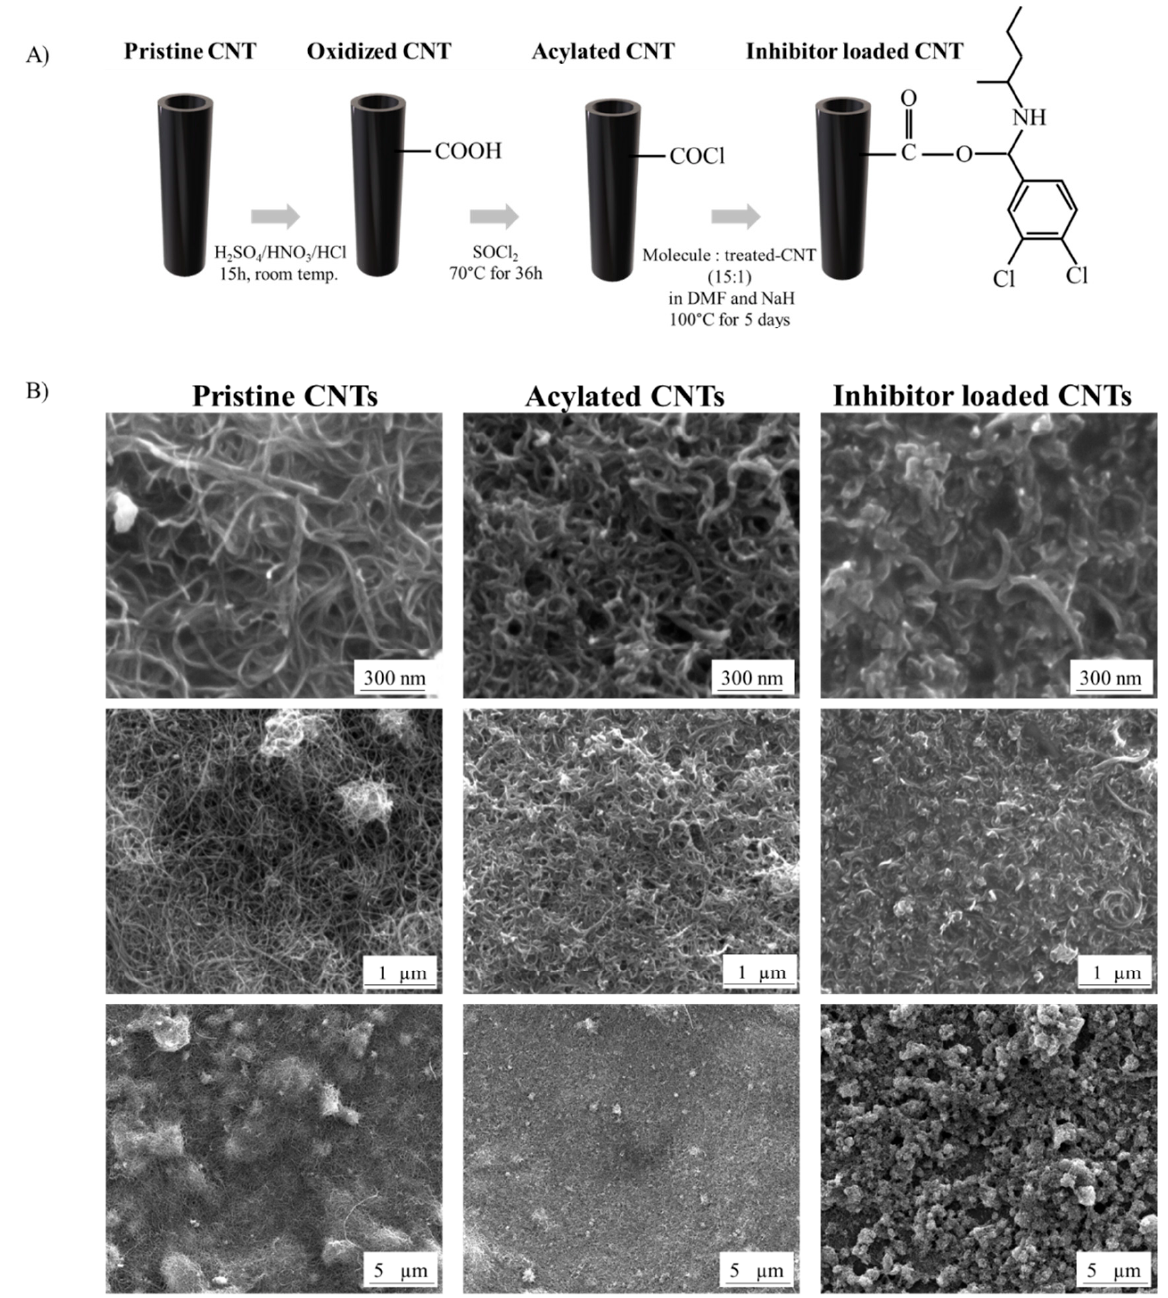
Figure 1. ( A ) Schematic representation of NSC405020 molecule grafted onto CNTs surface followed by ( B ) SEM images for pristine, acylated, and inhibitor loaded CNTs (low and high magnification).